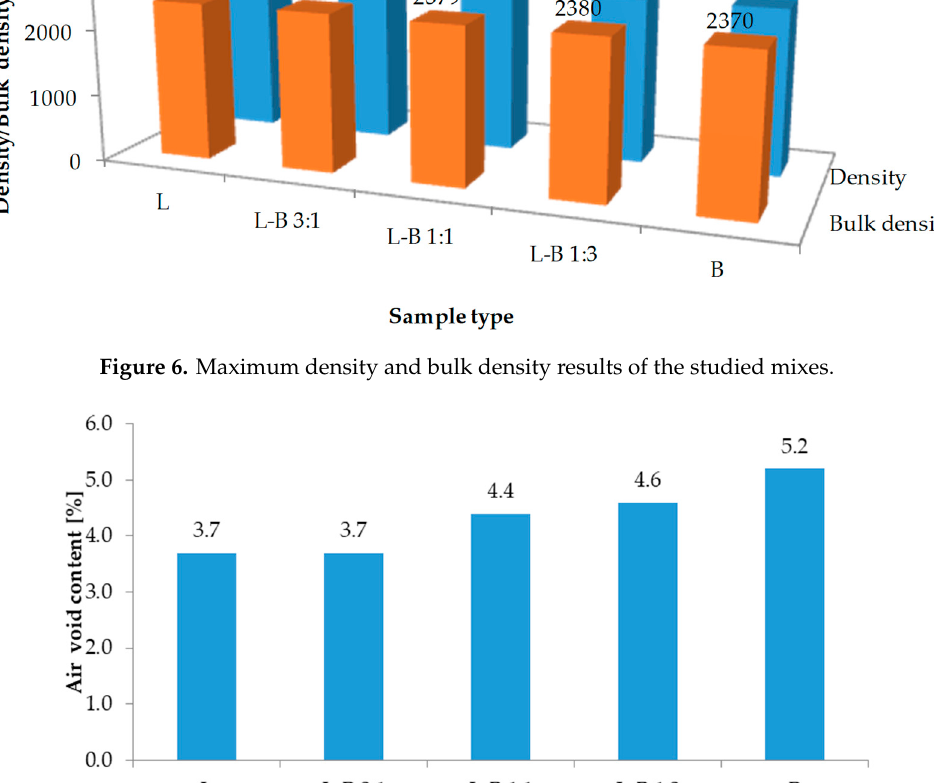
Figure 7. Air void content of the studied mixes.